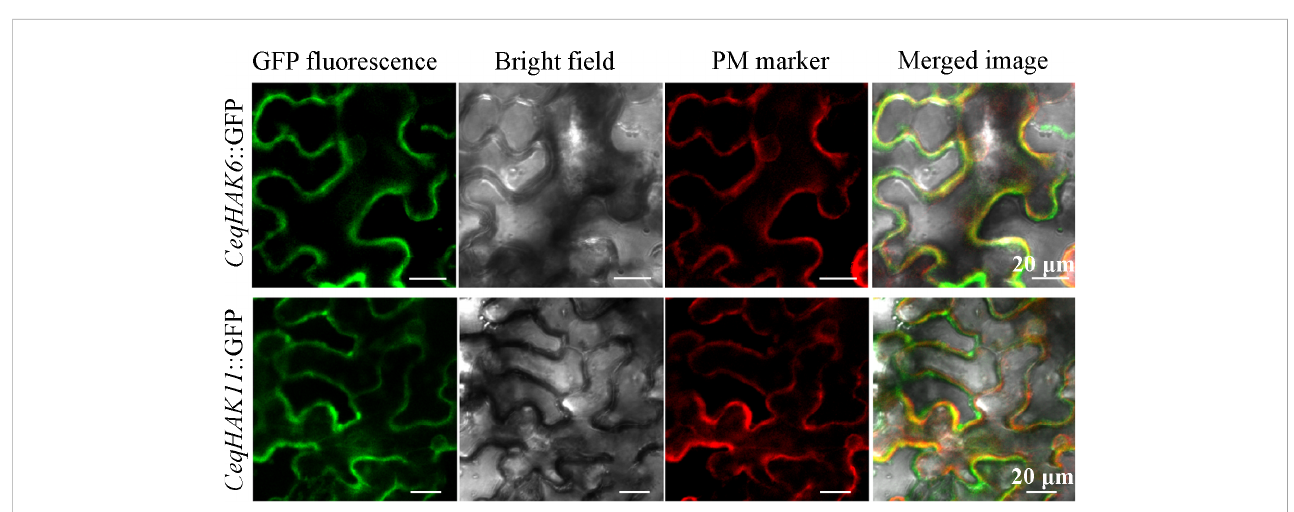
FIGURE 4 Subcellular location of CeqHAK6 and CeqHAK11 proteins. The fusion construct ( CeqHAK6 ::GFP or CeqHAK11 ::GFP) and PM protein were transformed in tobacco leaves. Confocal microscopy images of tobacco leaf epidermal